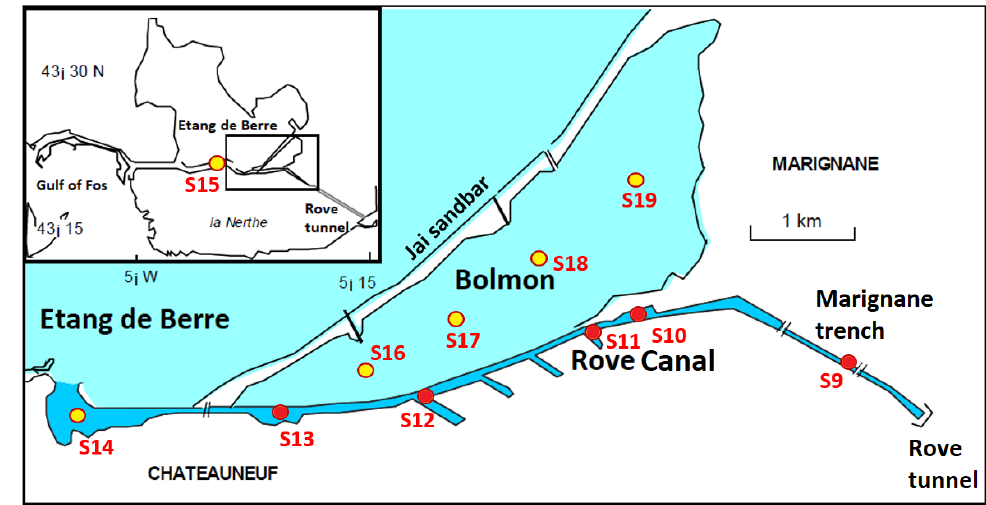
Figure 1. Rove Canal map (after [2]); red points S9–S19 correspond to measurement points of sediment composition.